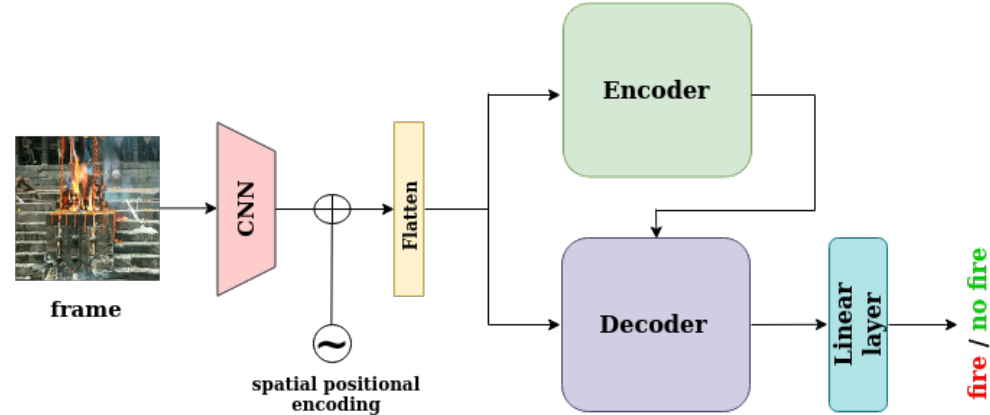
Figure 2. This figure depicts model architecture for the full-frame classification task. Both the encoder and the decoder consume the current frame that is under examination and output attention scores.